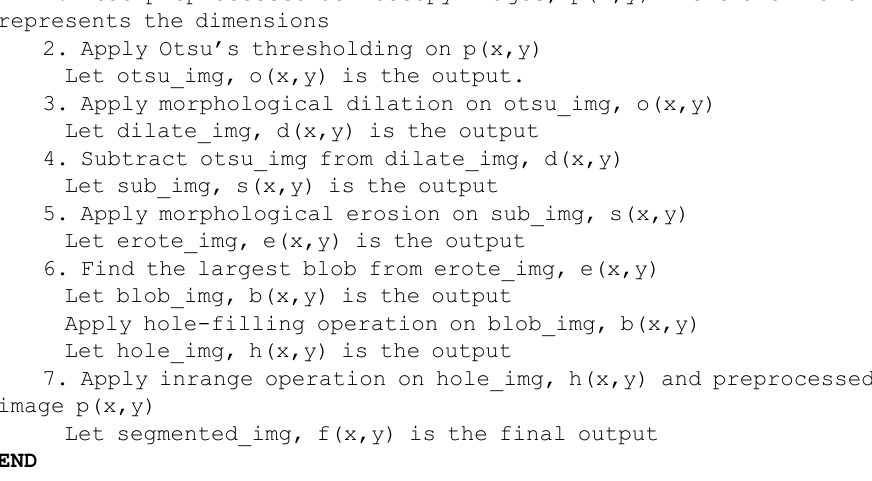
Algorithm 2. Image segmentation process.